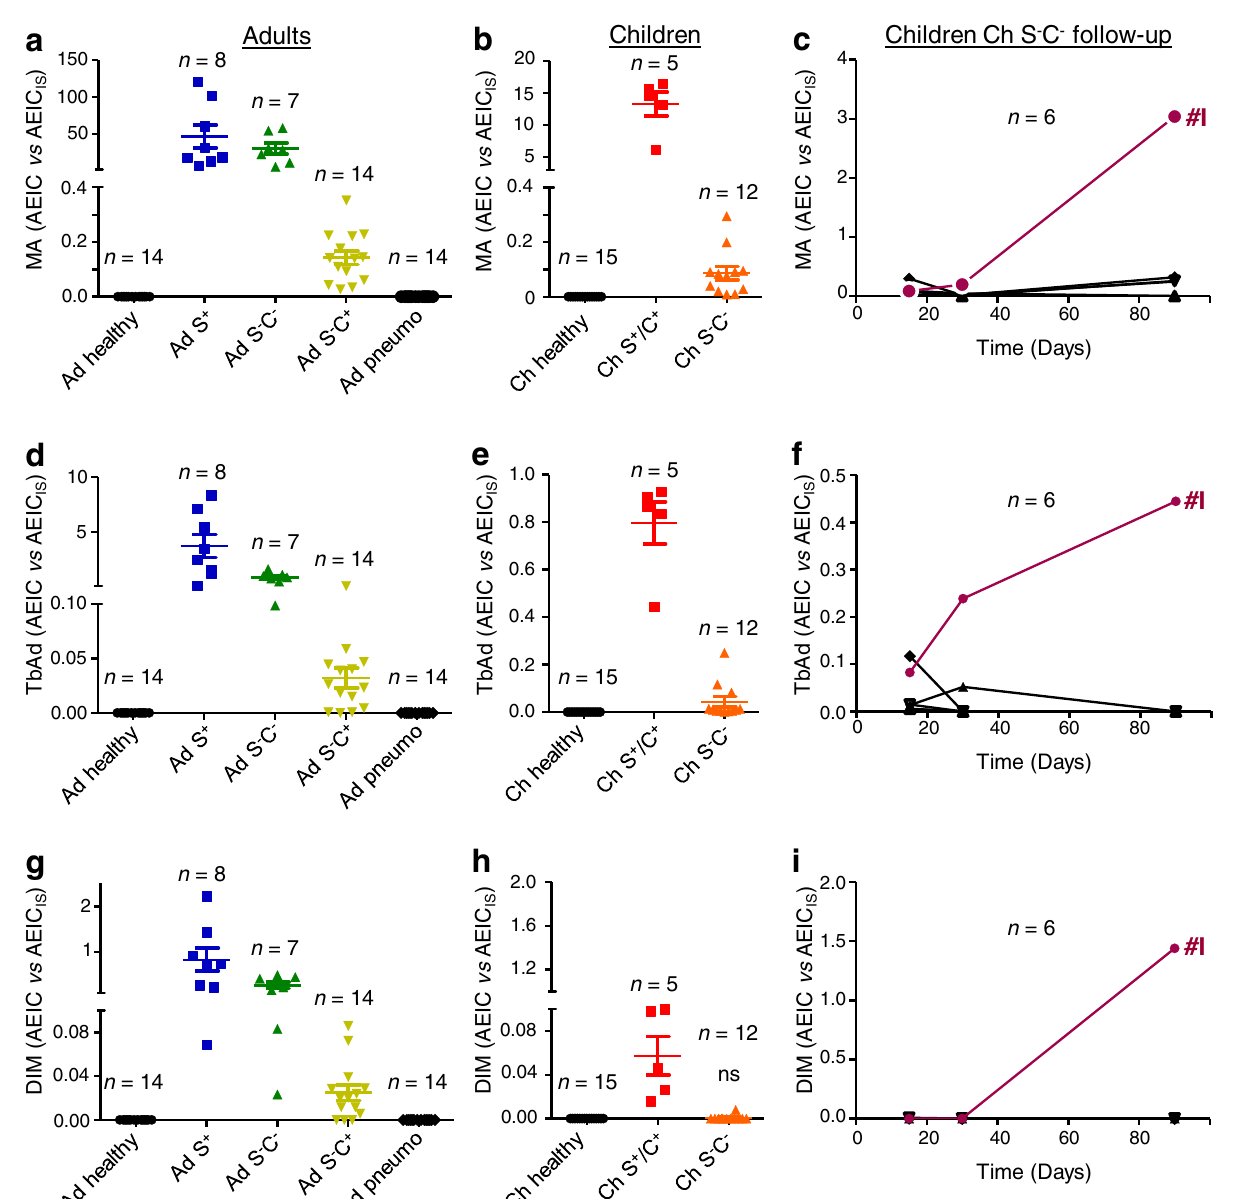
Fig. 3| M.tuberculosis lipidsandcorrespondingMSsignaturesdetectedinEBC from TB patients. a Negative MALDI-TOF mass spectrum of PI and PIMs. A struc- ture of tetra-acylated PIM 2 (Ac 2 PIM 2 ) that contains 2 palmitic (C 16 ), 1 stearic (C 18 ) and 1 tuberculostearic (C 19 ) acids is drawn. * indicate intense ions that do not correspond to PIM molecular species. b Negative MALDI-TOF mass spectrum of Ac 4 SGL. A structure that contains 2 hydroxyphthioceranyl (HPA) and 1 phthiocer- anyl (PA) (SL-II according to the nomenclature of Goren) is drawn. c Positive ESI-